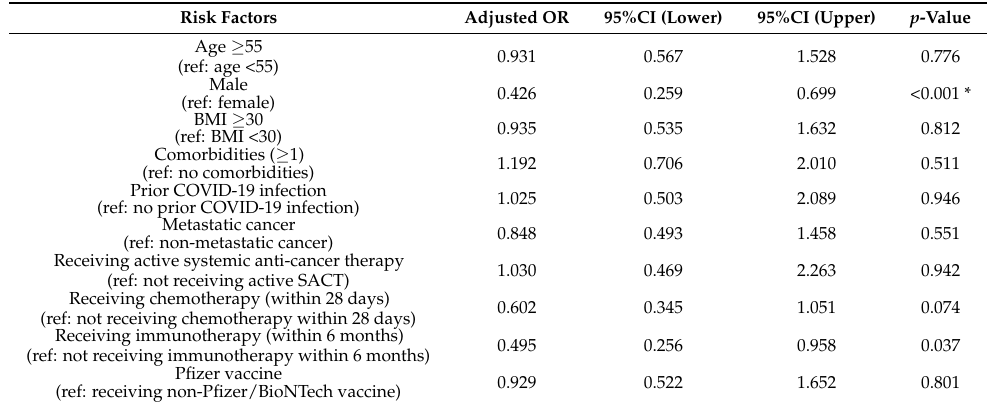
Table 5. Risk of total any grade vaccine-related adverse events ( n = 349). SACT, systemic anti-cancer therapy.